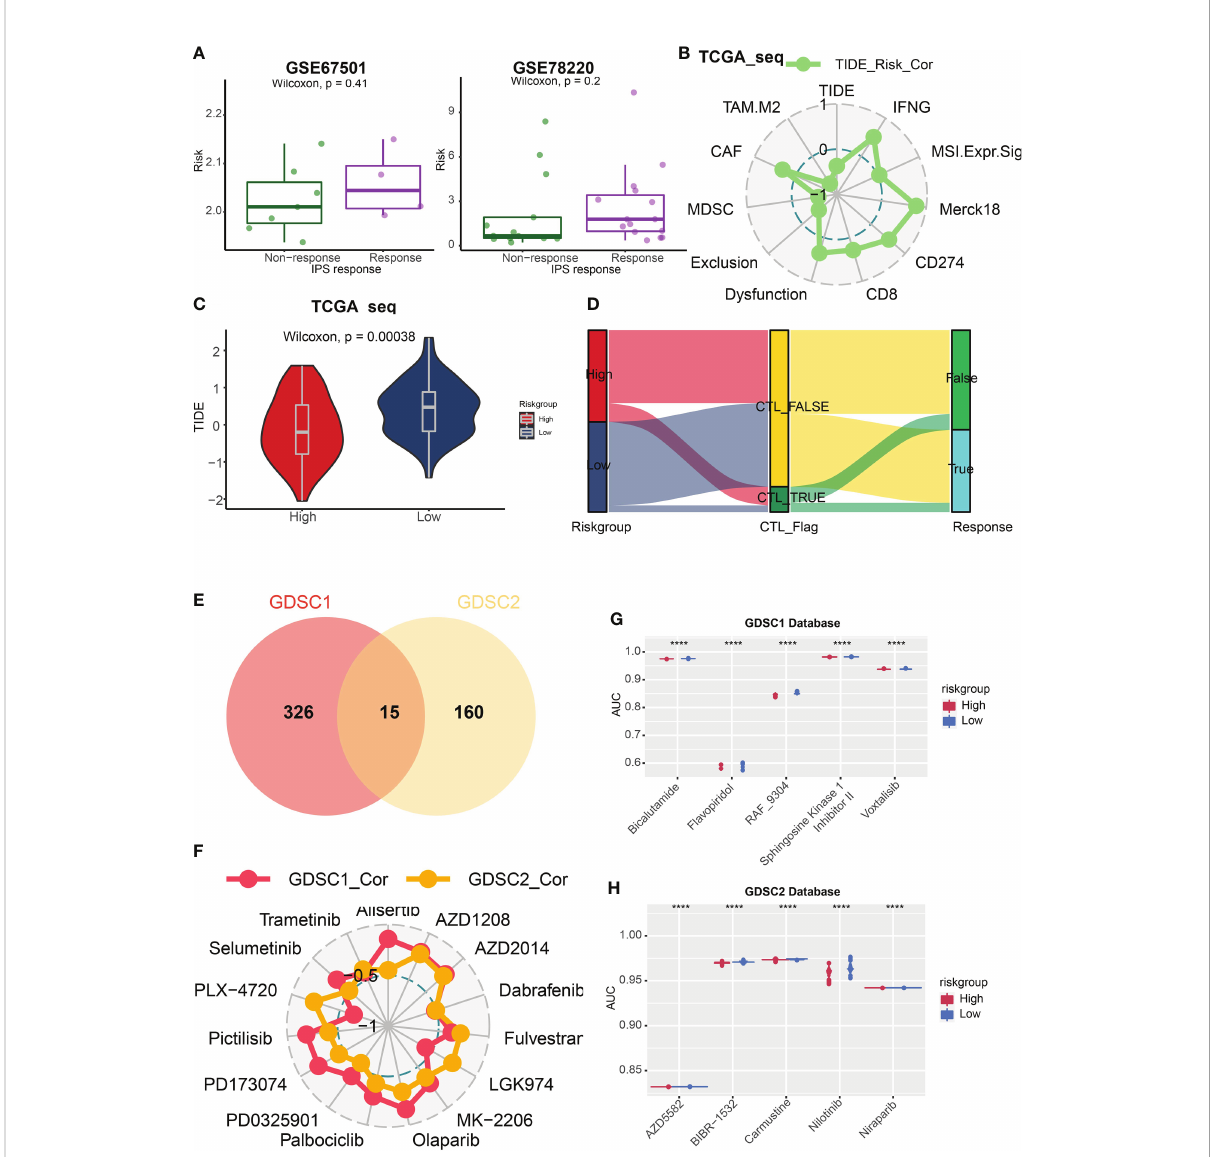
FIGURE 7 TIDE score and GDSC database analysis. (A) The box plots revealed the risk score of the response or non-response group in datasets GSE67501 and GSE78220. (B) Correlation analysis of risk score and TIDE associated scores. (C) The violin plot showed that the TIDE score was lower in high-risk group. (D) The Sankey diagram illustrated the prediction of ICB treatment response with respect to risk group. (E) 341 and 175 kinds of potential drug were identi fi ed in GDSC1 and GDSC2 databases respectively, and 15 kinds of them were overlapped whose AUC values were negatively correlated with risk score. (F) The relationship between these 15 drugs and risk score. (G, H) The box plots revealed fi ve drugs with the greatest negative correlation with risk scores in the GDSC1 (G) and GDSC2 database (H) respectively. P < 0.05, statistically signi fi cant. ****P <